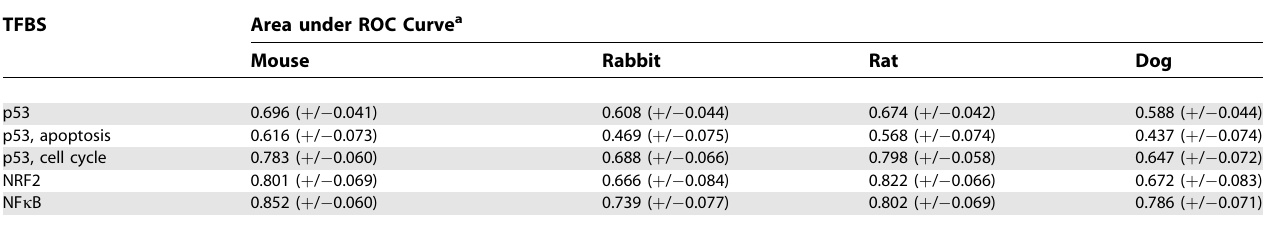
Table 6. Efficacy of Mammalian Conservation to Predict Human TFBSs